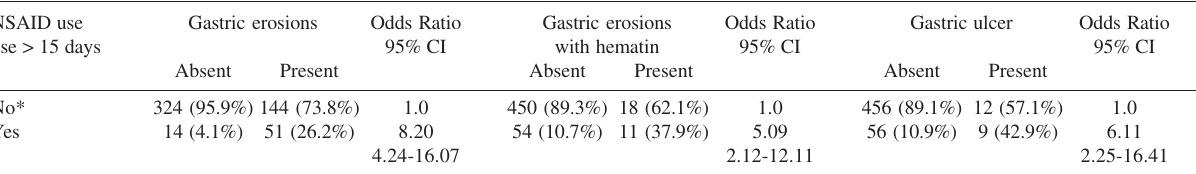
Table 2 - Association between nonsteroidal anti-inflammatory drugs (NSAID) use for more than 15 days and the occurrence of gastric lesions according to univariate